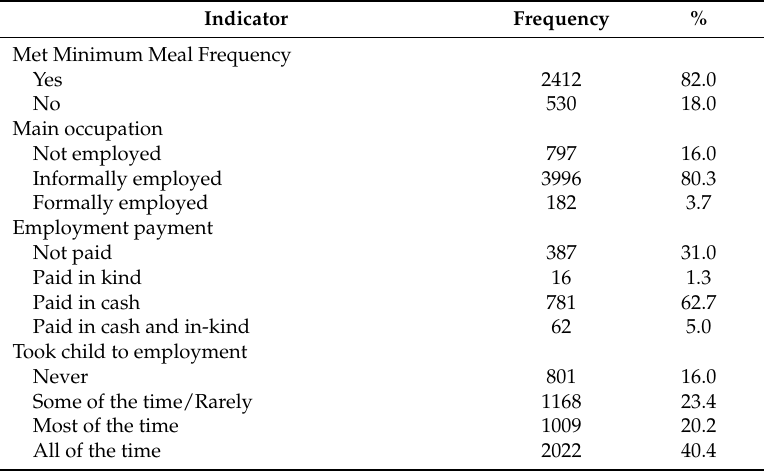
Table 2. Key Respondent